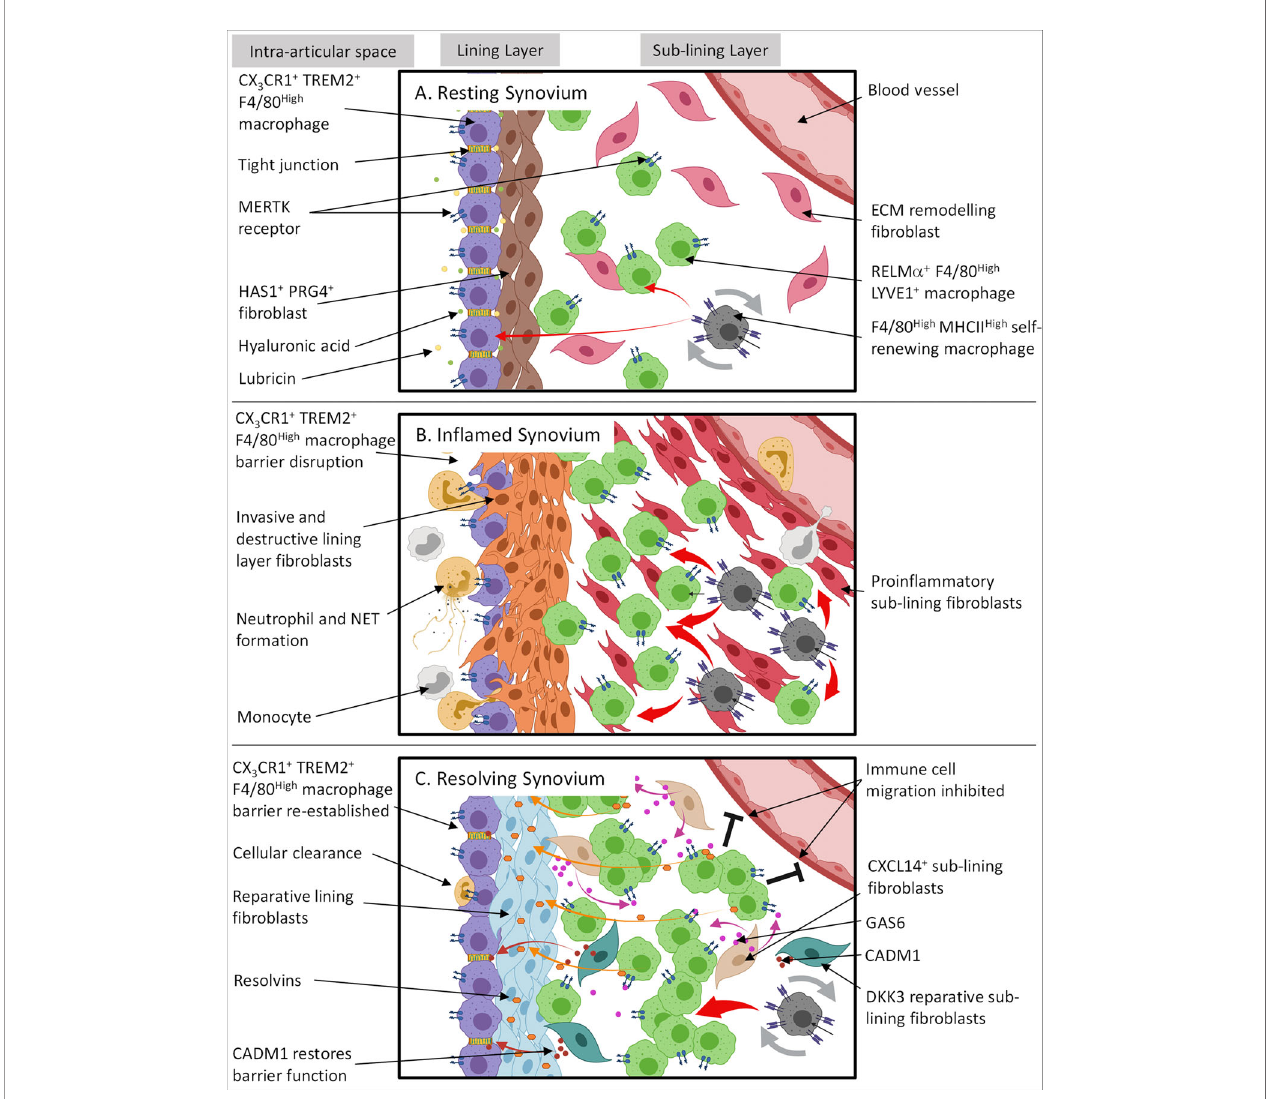
FIGURE 1 | The spatial and temporal coupling between tissue resident synovial cells determines joint homeostasis, in fl ammation and resolution in RA. (A) Resting synovial tissue consists of both tissue resident macrophages and fi broblasts. Tissue macrophages contain an immune-regulatory population expressing MERTK and are repopulated by CX 3 CR1 - F4/80 High MHCII High interstitial macrophages in the sub-lining. The lining layer is composed of highly organized, tight junction-mediated CX 3 CR1 + TREM2 + F4/80 High macrophages, forming an immunological barrier. Lining layer fi broblasts sit directly under CX 3 CR1 + TREM2 + F4/80 High barrier and secrete hyaluronic acid and lubricin into the intra-articular space via tight junctions to lubricate the joint cavity. The sub-lining is composed of sparsely distributed fi broblasts and RELM a + LYVE1 + F4/80 High macrophages where the former is thought to constantly remodel ECM following mechanical trauma. (B) Although during arthritis the CX3CR1 + TREM2 + F4/80 High macrophage barrier becomes dysfunctional allowing migrating in fl ammatory myeloid cells and activated lining fi broblasts to